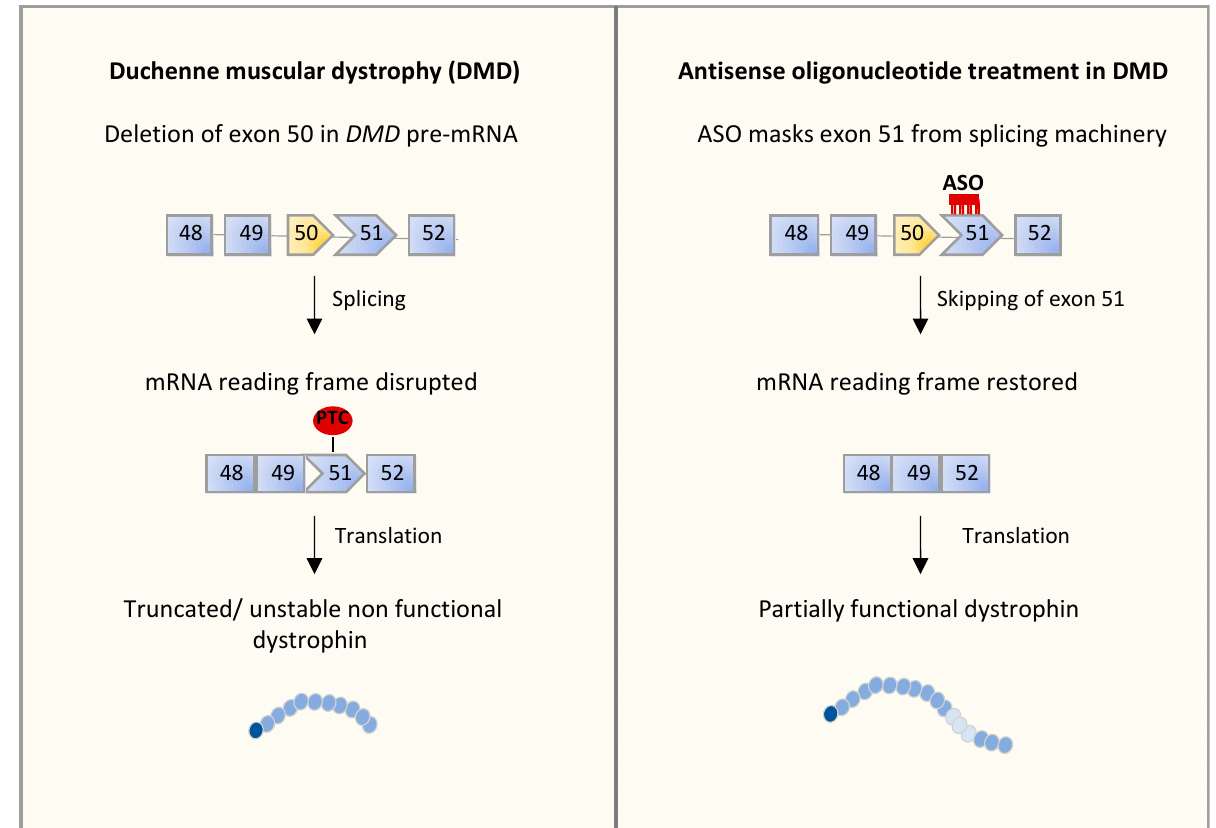
Figure 2. Antisense-oligonucleotide treatment for Duchenne muscular dystrophy (DMD). Patients with DMD display mutations which disrupt the open-reading frame of the dystrophin pre-mRNA. Schematic representation of DMD pre-mRNA from exon 48 to 52 is shown. Genomic deletion of exon 50 leads to an out-of-frame mRNA generating a premature stop codon. This results in the synthesis of a truncated non-functional dystrophin (left panel). Eteplirsen (ASO) specifically recognizes sequences of exon 51 of the DMD gene, allowing its exclusion from the mature mRNA. This restores the open-reading frame, promoting the synthesis of an internally deleted but partially functional dystrophin (right panel).